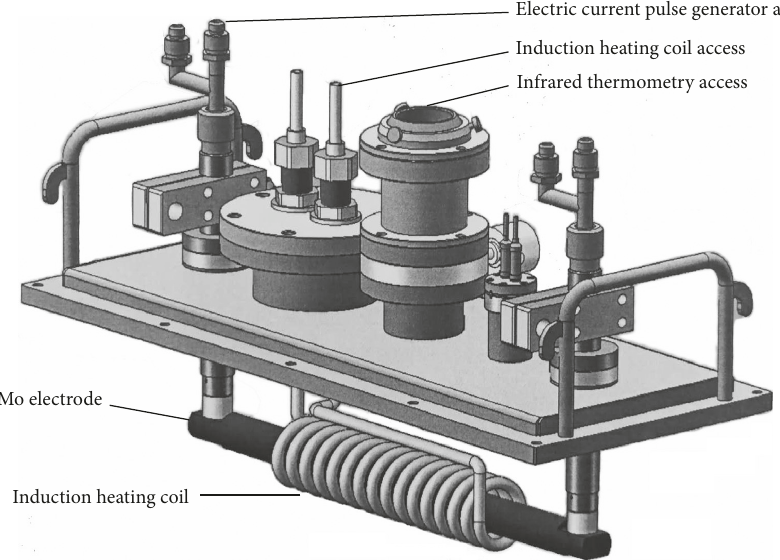
Figure 1: Schematic drawing of experimental setup.